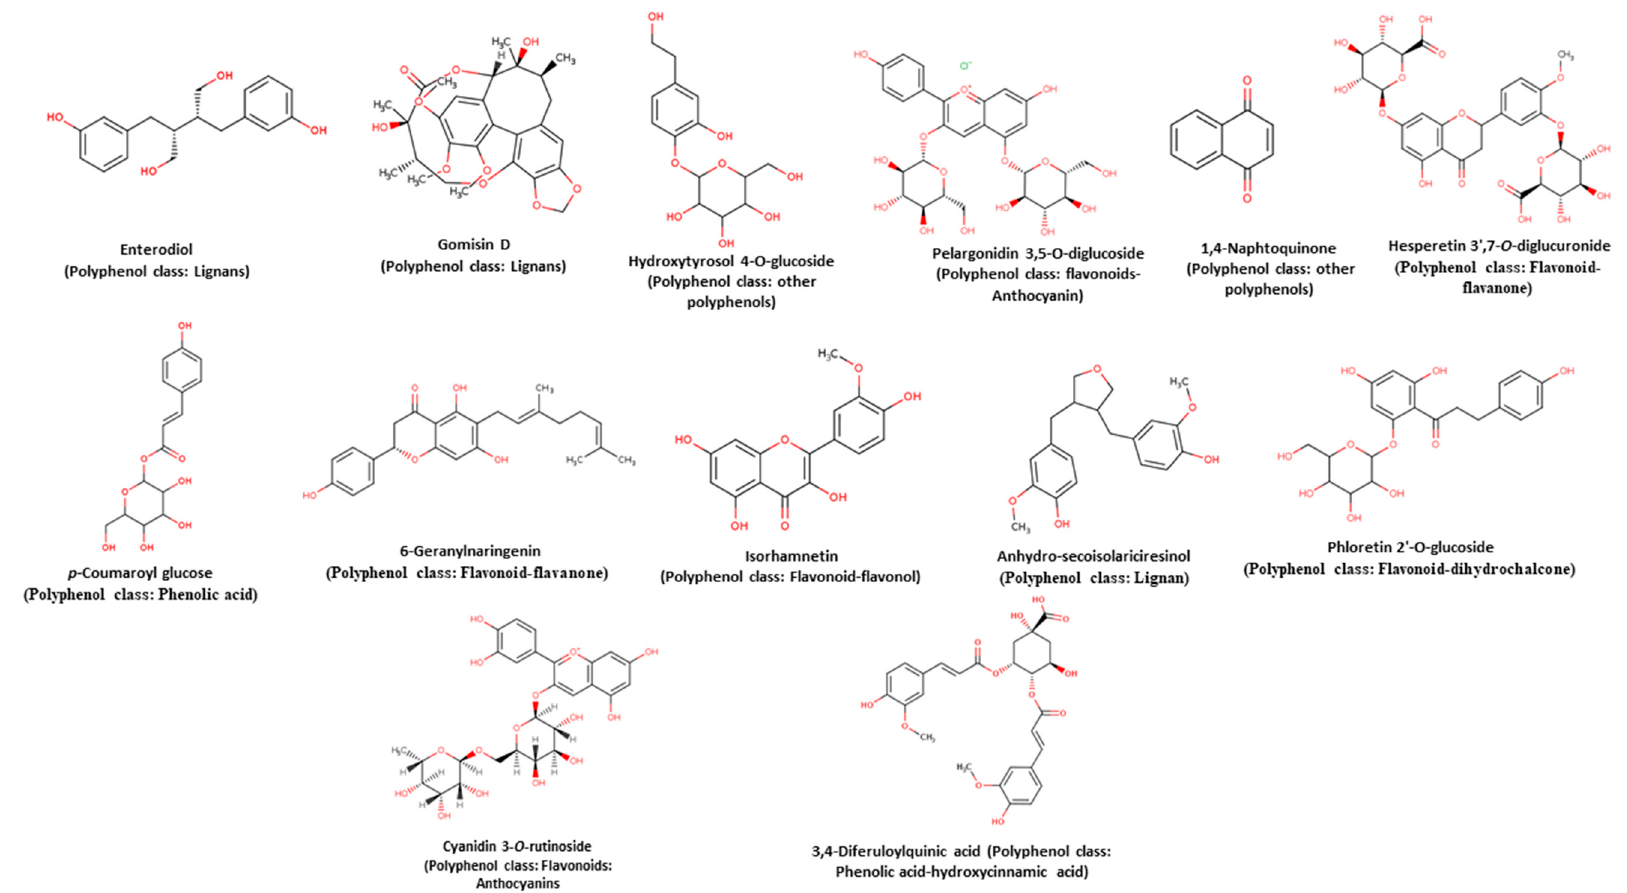
Figure 5. Structures of phenolic compounds from chickpea identified by UPLC-MS. The images were taken from the database on polyphenol content in foods [53].